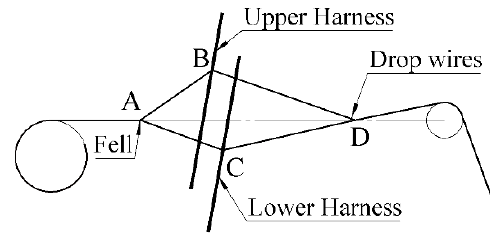
Figure 3. Schematic diagram of the shed.